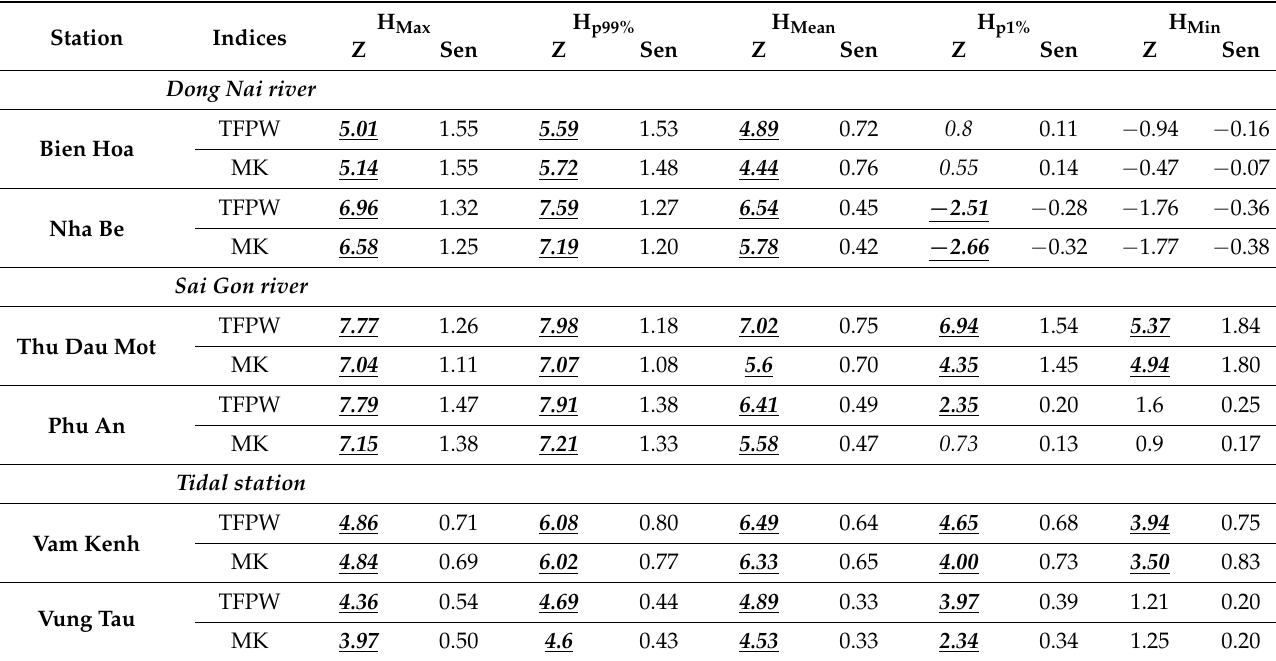
Table 3. Water level trend analysis based on Mann-Kendall, TFPW tests, and Sen’s slope.